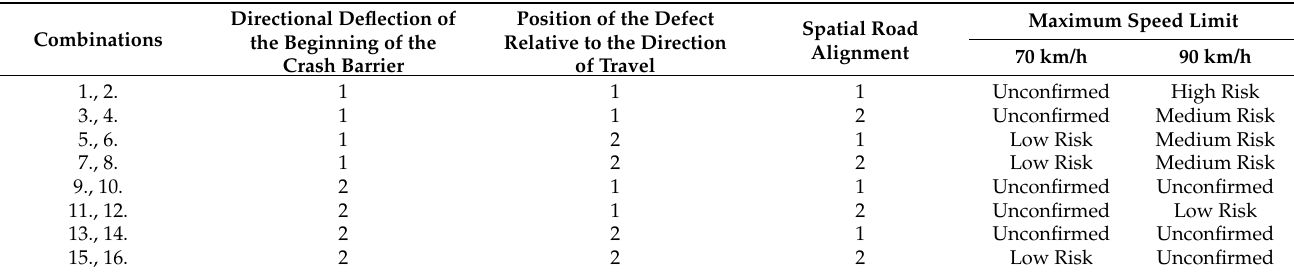
Table 9. Hypothesis I.—Short turned down end of the crash